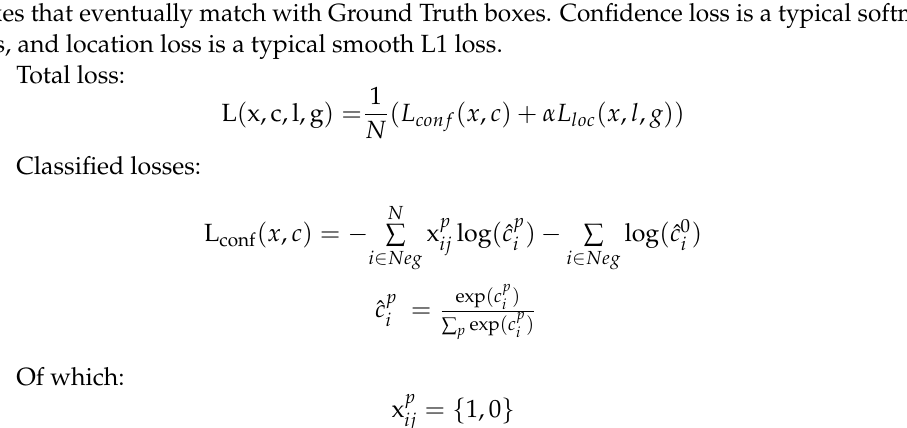
confidence loss and location loss, default = 1, and N denotes the total number of default boxes that eventually match with Ground Truth boxes. Confidence loss is a typical softmax loss, and location loss is a typical smooth L1 loss.